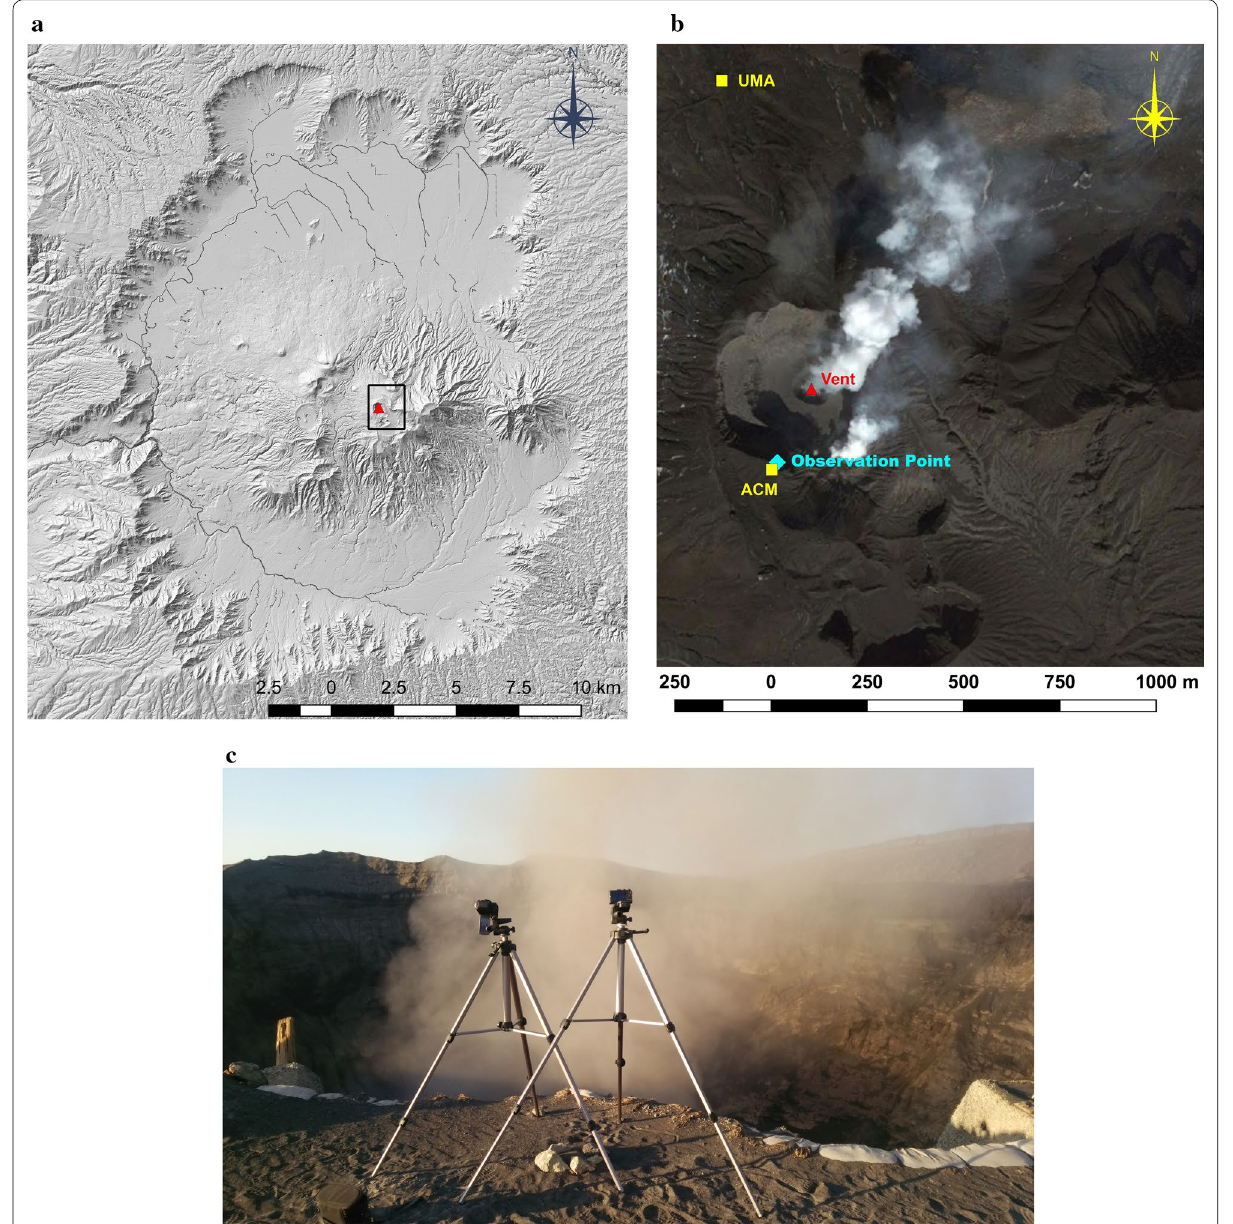
Fig. 1 a A shaded relief map of the Aso caldera. The black square area is a blown-up image of the area in ( b ). b Location of the active craters in the 2015 eruptions, the video footage, and two monitoring stations of the Aso Volcano Laboratory, Kyoto University (ACM and UMA), based on Google Maps. c The view from the location where the video footage was installed. The view is looking in a northeasterly direction from the ACM